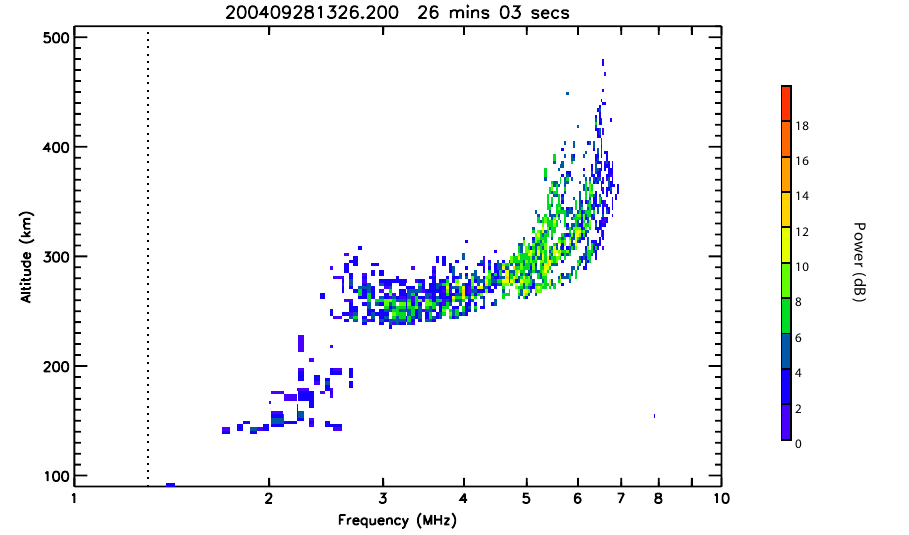
Fig. 16. Svalbard ionogram for 13:26 UT, 28 September